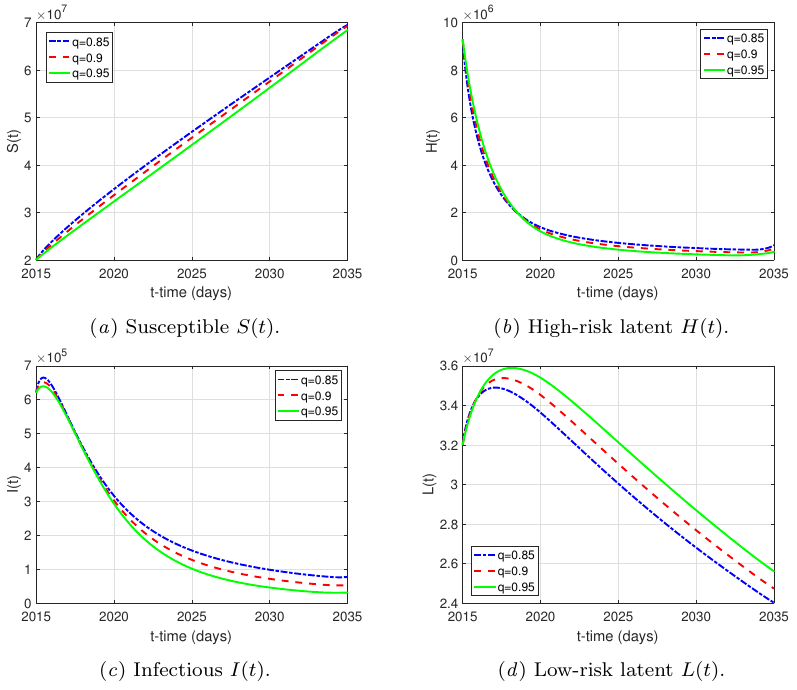
Figure 2. Case C 123 : Epidemiological classes.